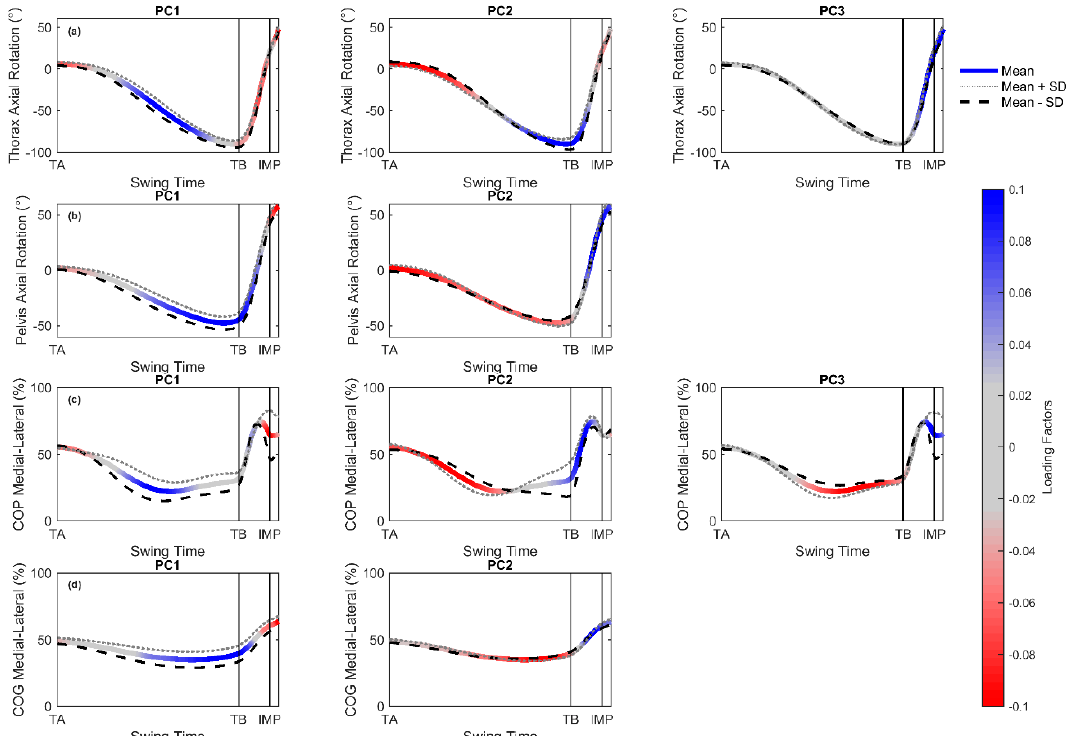
Figure 3. Mean curve (colour graded by PC loading factors) ± one SD of PC scores multiplied by loading factors for ( a ) thorax axial rotation (PC1, PC2 and PC3), ( b ) pelvis axial rotation (PC1 and PC2), ( c ) COP medial-lateral (PC1, PC2 and PC3) and ( d ) COG medial-lateral (PC1 and PC2). Golfers with PC scores of mean + one SD followed dotted grey line and those with PC scores of mean—one SD followed the dashed black line.